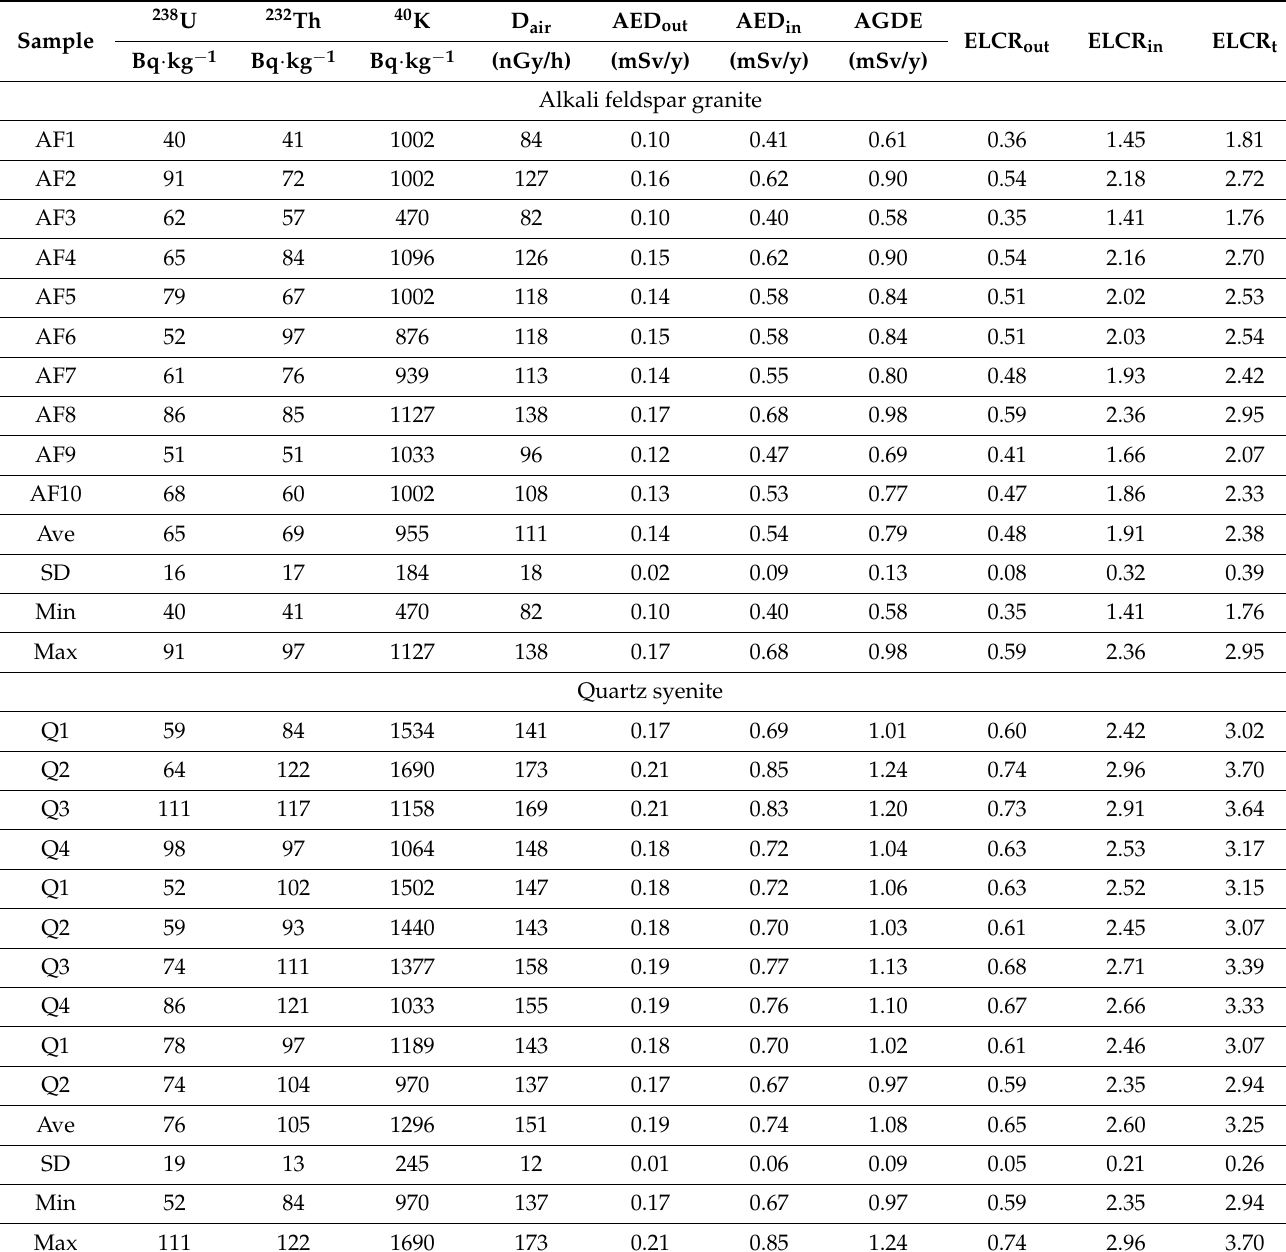
The skewness values characterize the asymmetric distribution following basic data analysis of radionuclide activity concentrations, with positive values indicating that the asymmetric distribution tail is expanded towards positive values and negative values indicating that the tail is expanded to negative values. As seen in Table 4, the skewness values of A U are + ve values in alkali feldspar granite and quartz syenite samples while –ve values in the syenogranite